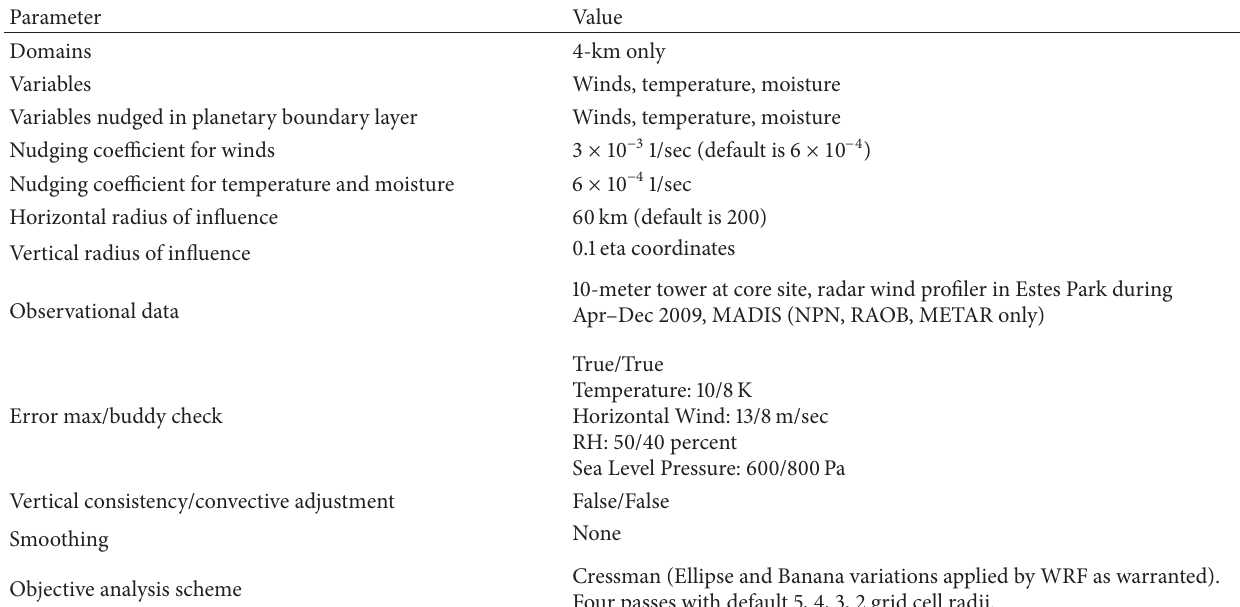
Table 2: Final observational nudging parameters for WRF. Most values are the default values.